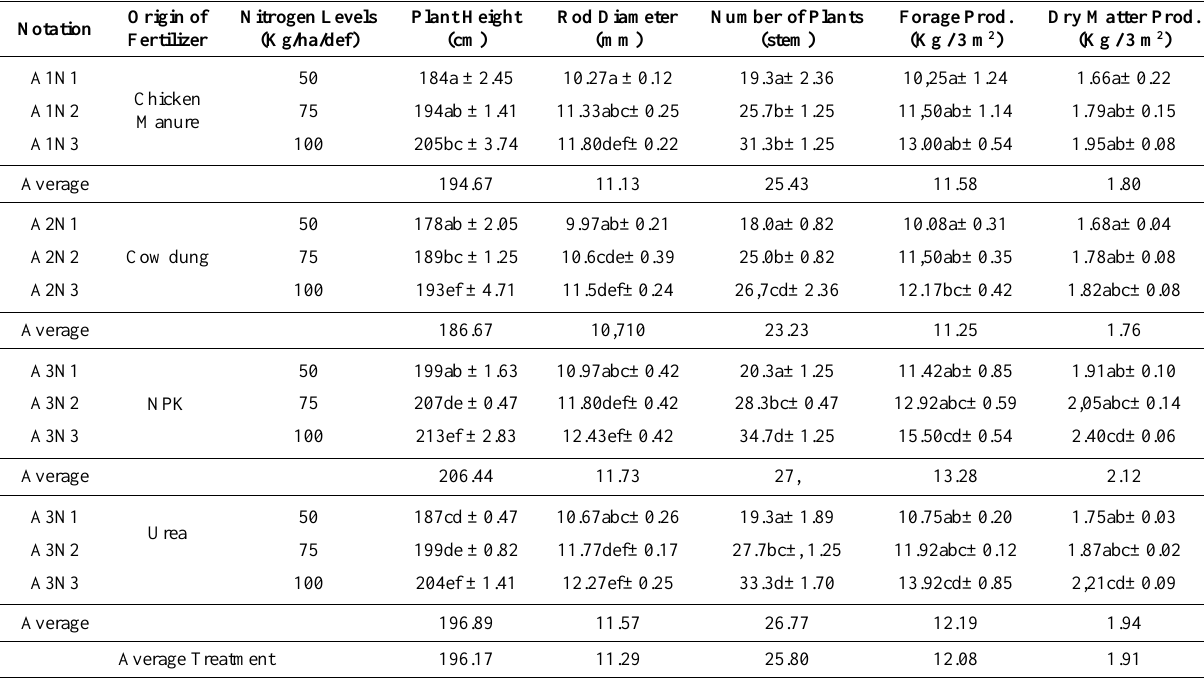
Table 2. Average Research